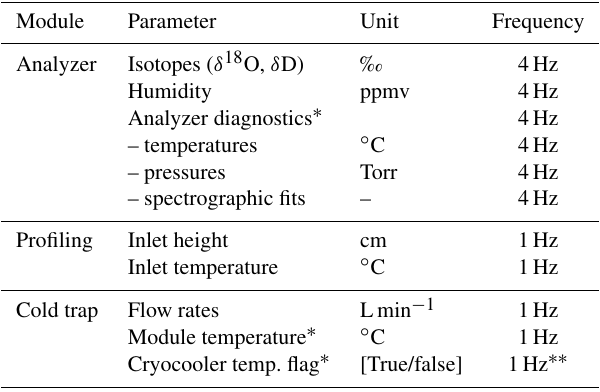
∗ indicates parameters classified as metadata, providing information on the quality of the data collected. ∗∗ While flow rates and metadata of the cold-trap module are recorded as 1Hz, sample collection times